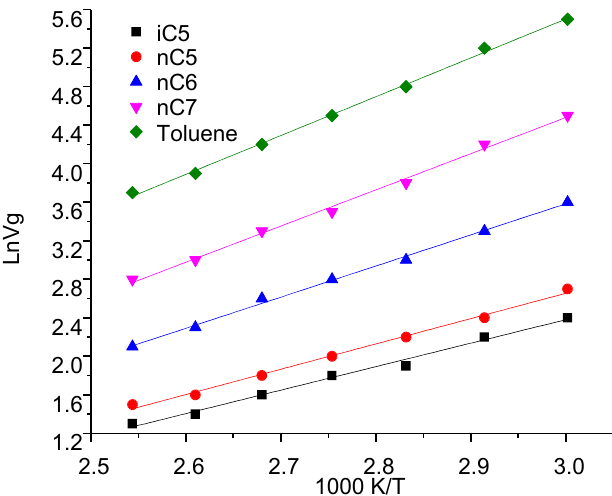
V , vs. the inverse of absolute temperature